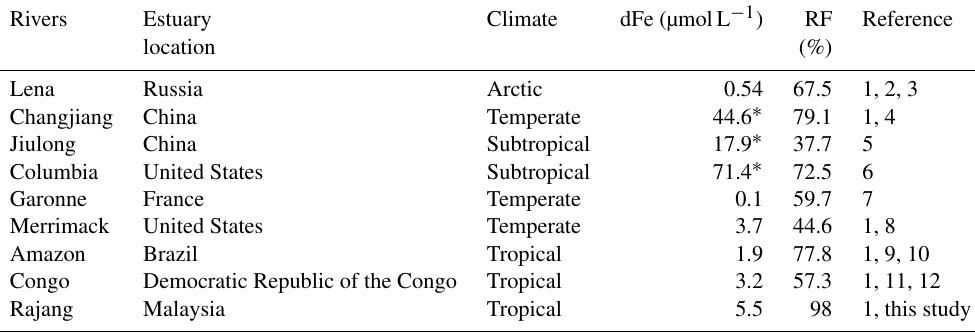
Table 2. Concentration of dFe and the removal factor (RF) in some rivers. Rivers Estuary